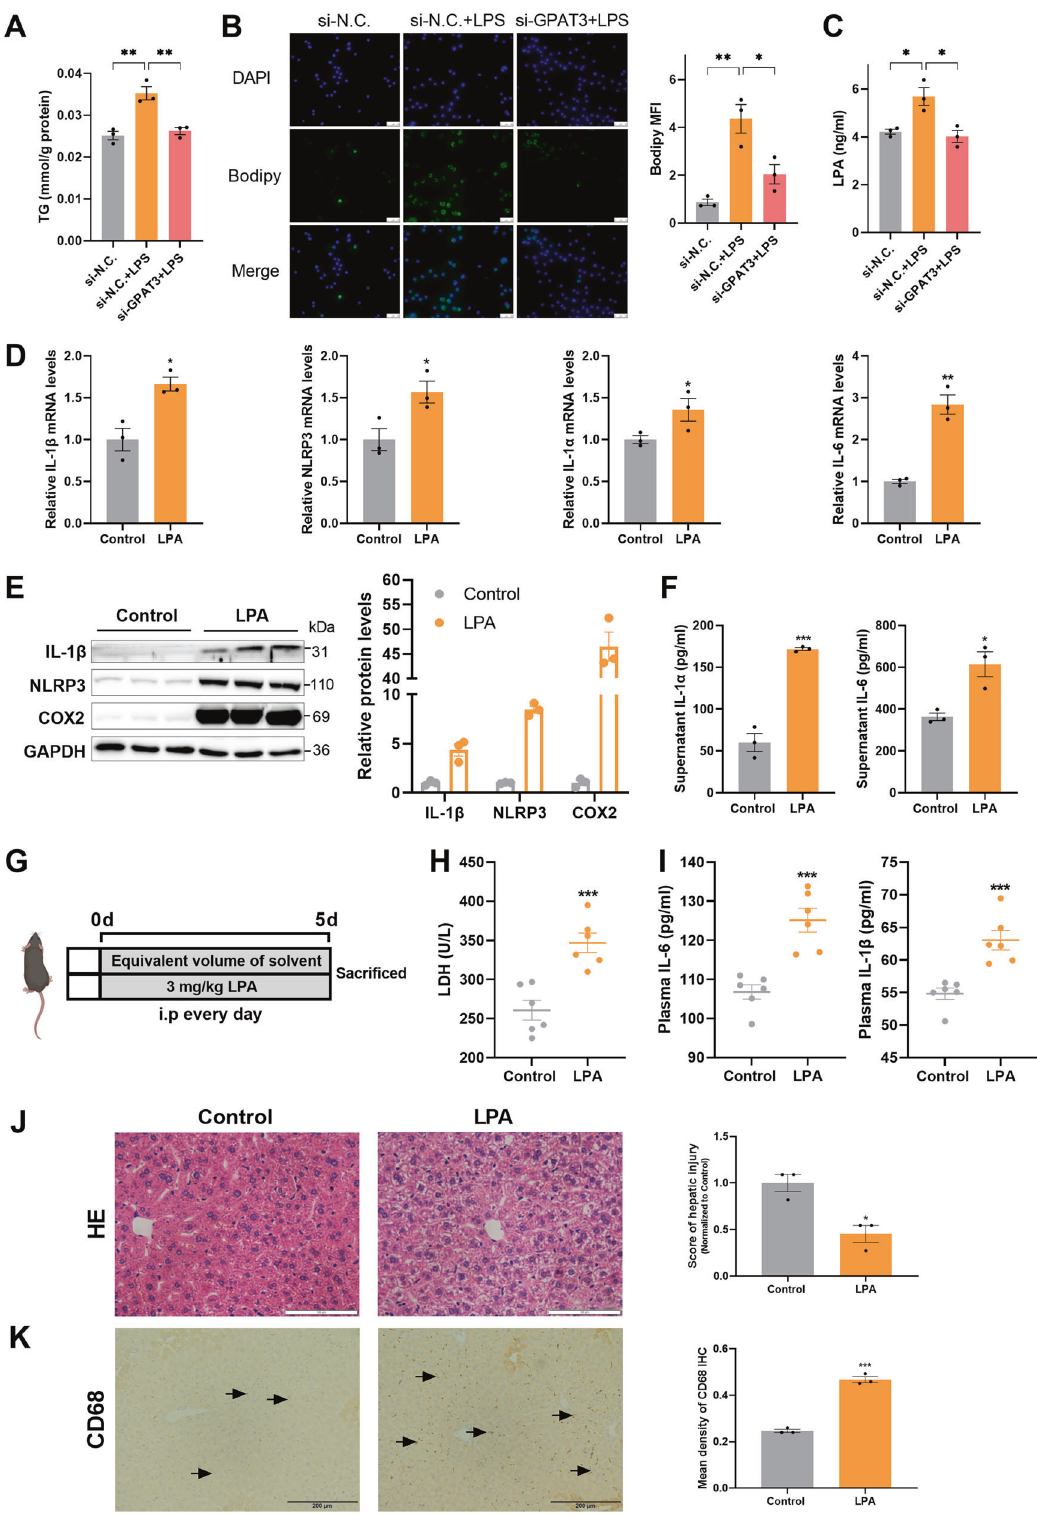
Fig. 5 Exogenous LPA enhanced in fl ammatory response in vitro and vivo. A Effect of si-GPAT3 or si-N.C. on TG content in KCs stimulated with LPS (1 μ g/ml) for 24 h ( n = 3). B Bodipy 493/503 fl uorescence visualized by fl uorescence microscopy (scale bars represent 50 μ m) ( n = 3). C LPA concentrations in the supernatant of KCs after LPS (100 ng/ml 12 h) stimulated and with or without si-GPAT3 ( n = 3). D The mRNA expression of IL-1 β , NLRP3, IL-1 α and IL-6 in KCs treated with LPA (30 μ M 12 h) ( n = 3). E, F The effects of exogenous LPA (30 μ M 12 h) on the protein expression of in fl ammatory factors IL-1 β , NLRP3, COX2, IL-1 α and IL-6 in KCs ( n = 3). G Experimental design of mice treated with LPA. H, I The contents of LDH, IL-6 and IL-1 β in plasma of LPA treated with mice ( n = 6). J, K Representative images and quanti fi cation of HE staining (Scale bars represent 100 μ m) and CD68 IHC (Scale bars represent 200 μ m) after LPA treatment in liver of mice ( n = 3). Data represents mean ± SEM. * P < 0.05, ** P < 0.01, *** P < 0.001. Cell Death and Disease (2023)